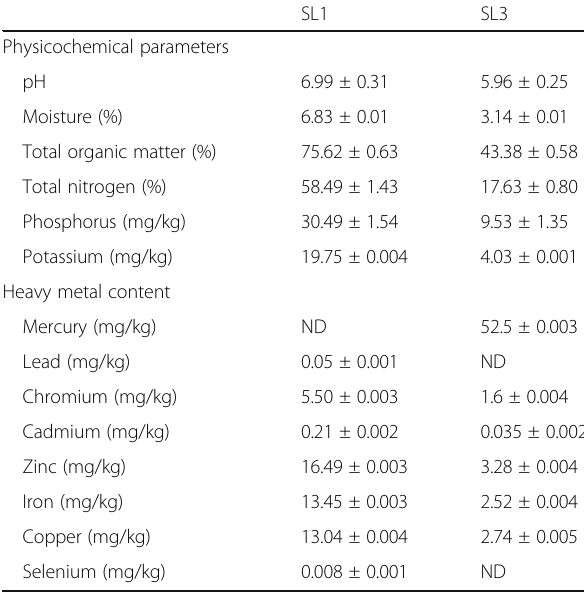
Table 1 Dynamics of physicochemical properties and heavy metal content of agricultural soil (SL1) and mercury-inundated agricultural soil (SL3) SL1 Physicochemical